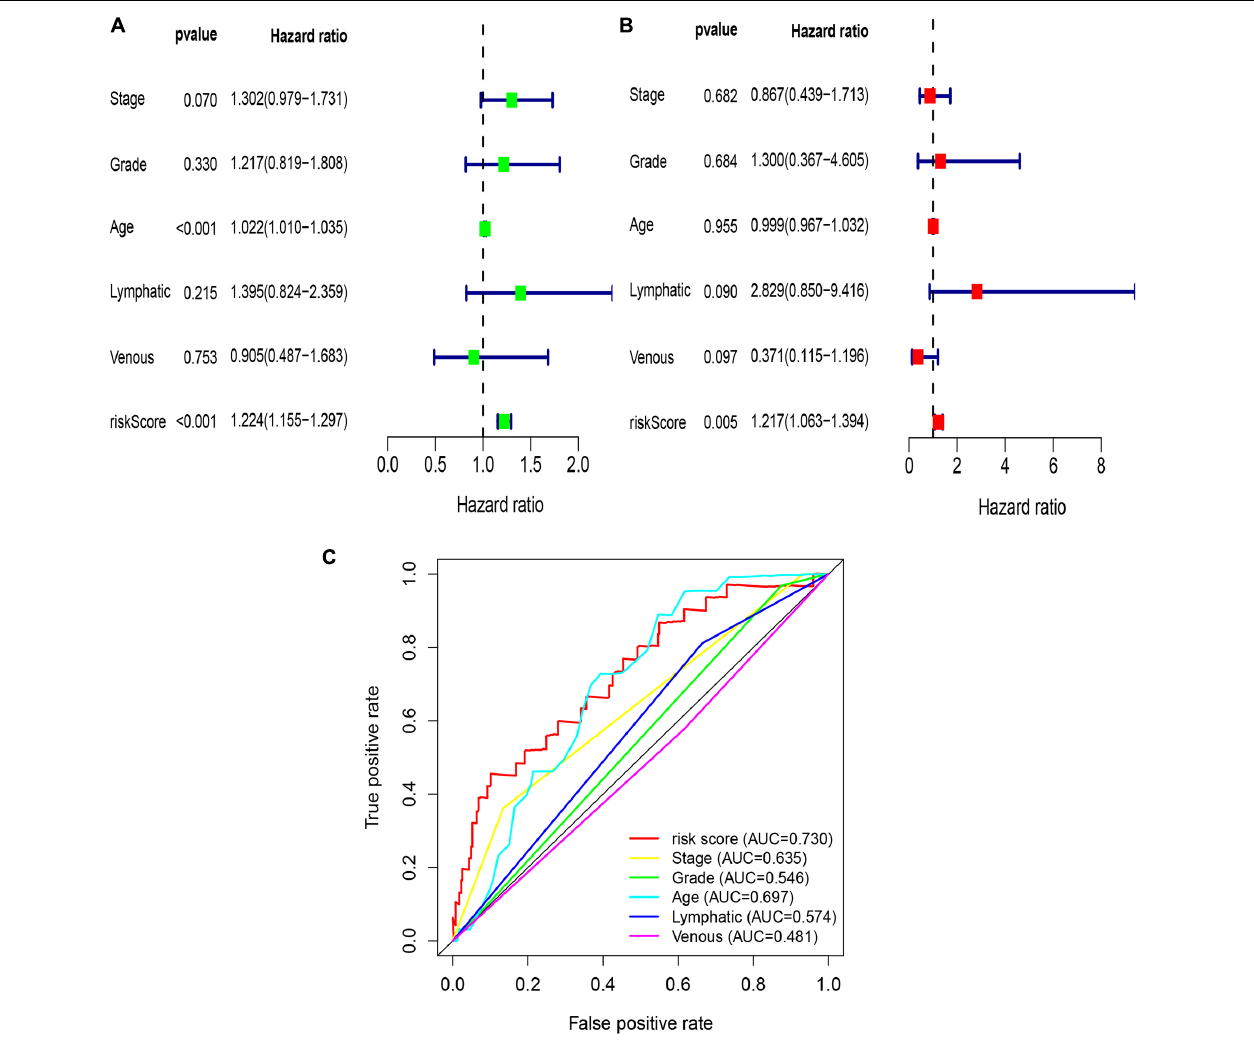
FIGURE 3 | Univariate and multivariate Cox regression analyses based on the risk score and other clinical features in TCGA-OV dataset. (A) Univariate Cox regression analyses. (B) Multivariate Cox regression analyses. (C) ROC curve analysis of the risk score and other clinical